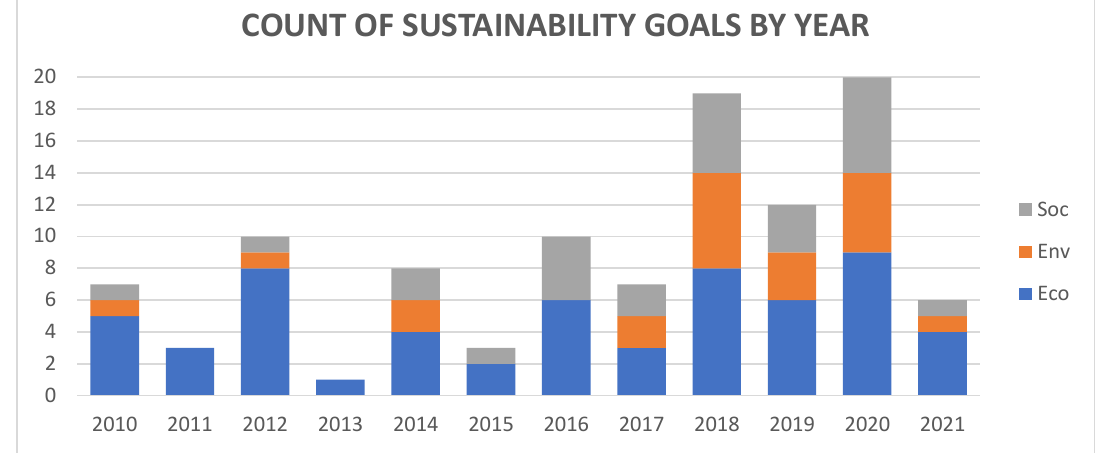
Figure 5. The count of each of the three goals of sustainability against the year the paper was published.